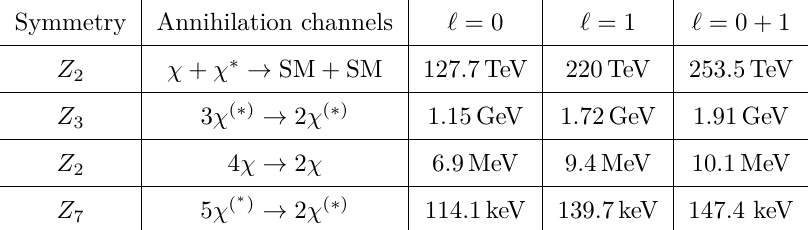
Unitarity upper limits on thermal DM mass in a radiation dominated Universe, for different dominant annihilation topologies of k → 2 type, with k ≥ 2 . In order to obtain a precise prediction, in each case a minimal scenario with (real or complex) scalar is considered, with a minimal Z N DM stabilization symmetry. The upper bounds are shown for three cases in each scenario, with the dominant annihilation mode being from (1) s-wave, (2) p-wave and (3) both s- and p-wave initial